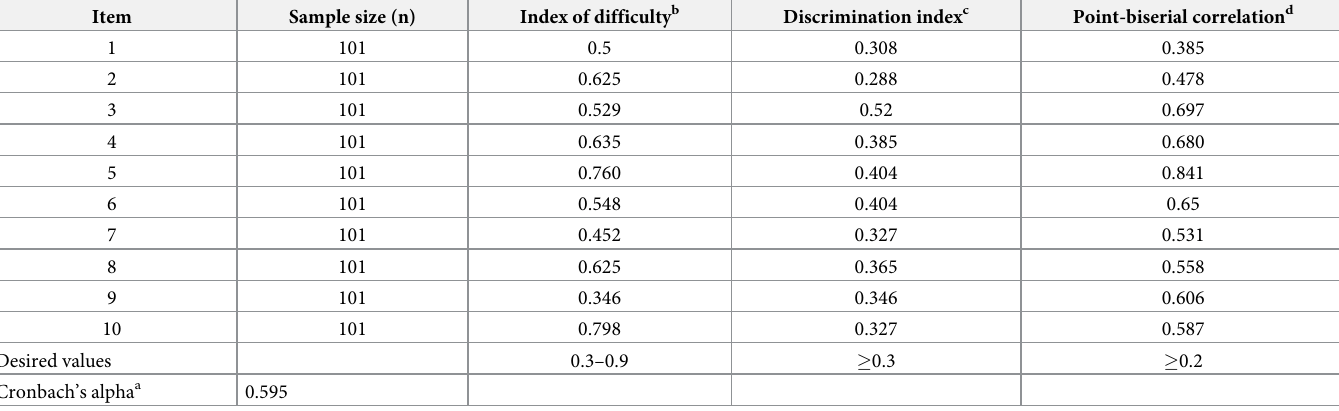
Table 4. Spring 2021 administration item analyses: Difficulty, reliability, and discriminatory power of the student post-assessment.